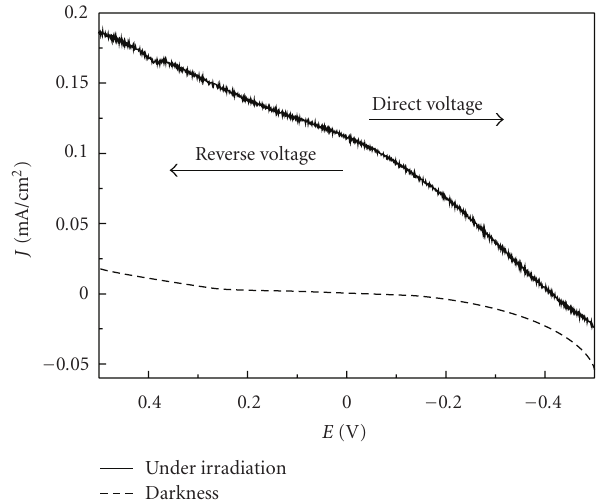
Figure 19: J-V characteristic obtained on PEDOP-based DSSC in the presence of Li + 0.3M. 10 seconds polymerization time.